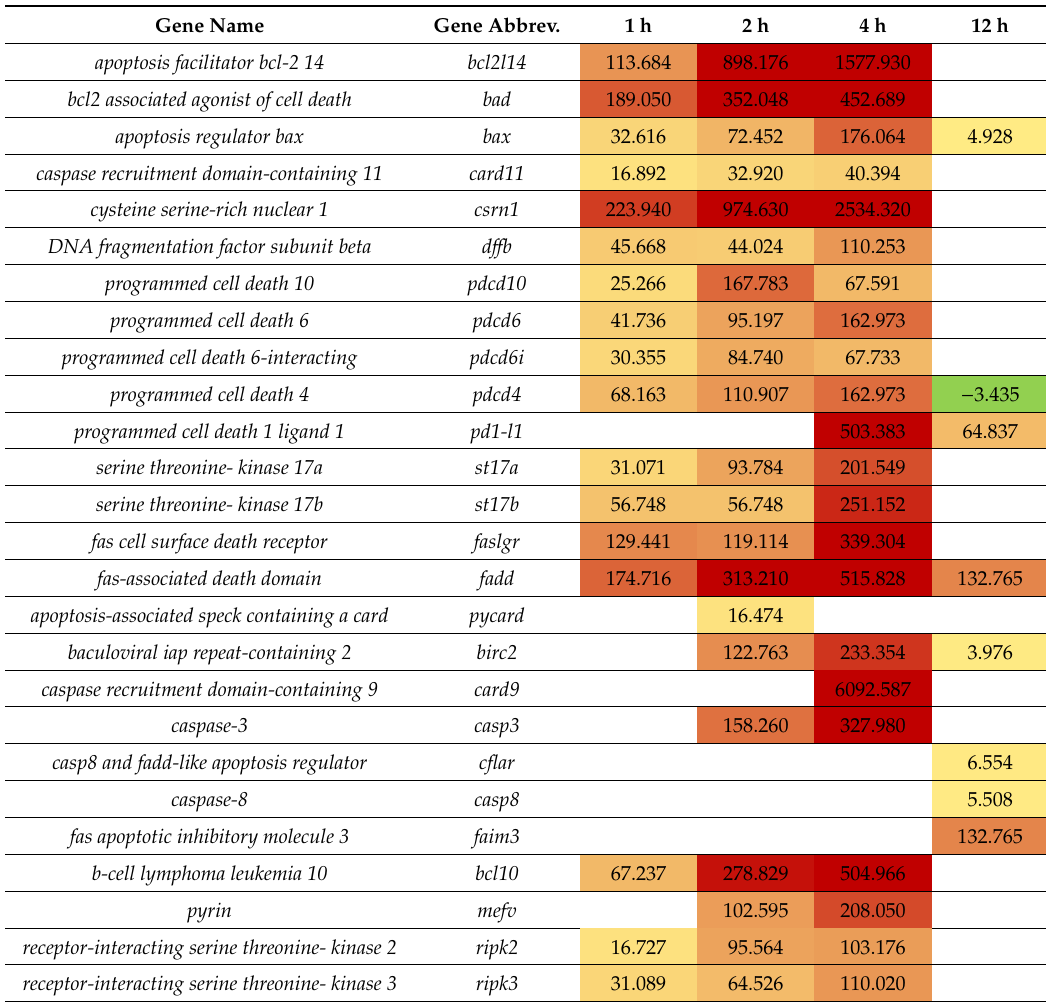
Table 7. Heat map showing a group of DE genes in turbot peritoneal cells at 1, 2, 4 and 12 hpi, including many genes involved in cell death. Results are expressed as mean expression ratios of groups 1, 2 and 4 hpi vs. 0 h, or 12 hpi vs. PBS. There were no DE genes at 48 hpi. Red indicates increased gene expression levels; green indicates decreased